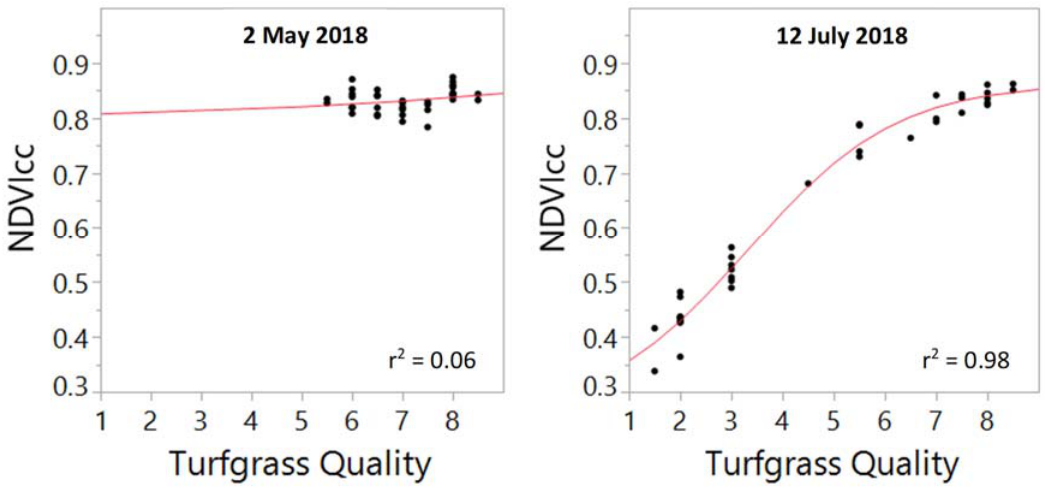
Figure 2. Example of nonlinear four parameter logistic regression used for the normalized di ff erence vegetation index measured by the Crop Circle ACS-430 (NDVIcc) on the individual dates of 2 May 2018 and 12 July 2018. Table 7. Coe ffi cient of determination ( r 2 ) of individual dates comparing hyperspectral and multispectral responses between vegetation indices and measured turfgrass parameters using a nonlinear regression four-parameter logistic model.